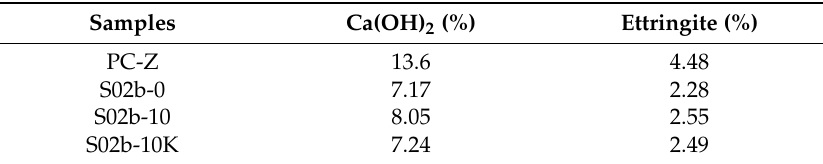
Table 6. The amount of Ca(OH) 2 and ettringite in the cement pastes at 56 days.